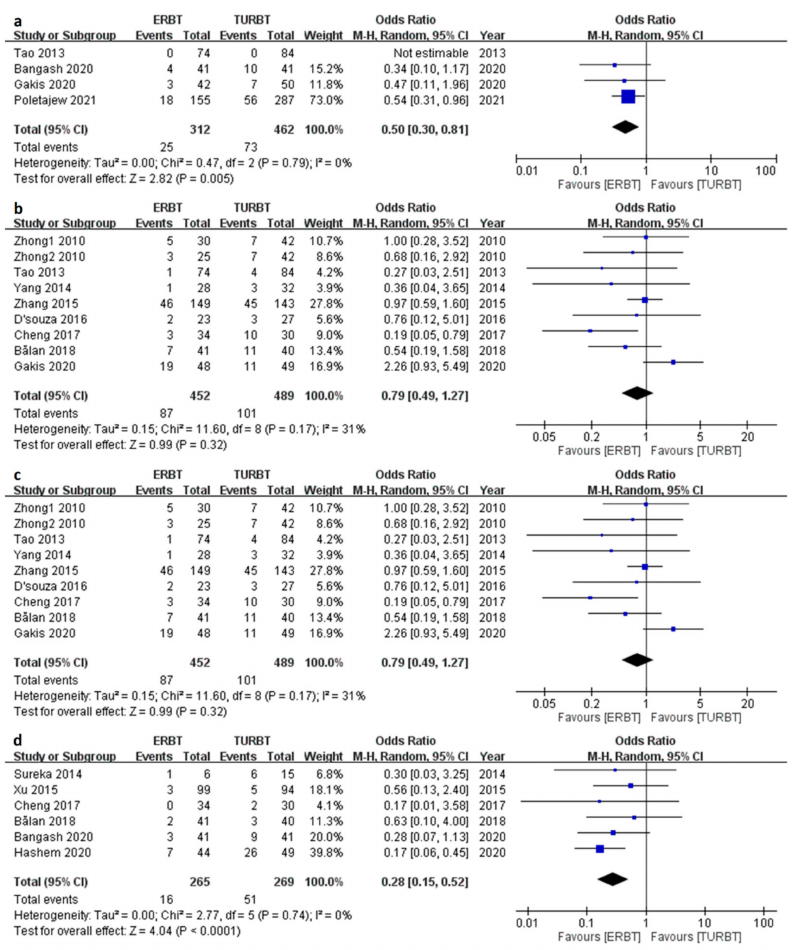
Figure 3. The forest plot of recurrence related parameters between the two groups. ( a ) The forest plot of 3-month recurrence rate. ( b ) The forest plot of 12-month recurrence rate. ( c ) The forest plot of 24-month recurrence rate. ( d ) The forest plot of same-site recurrence